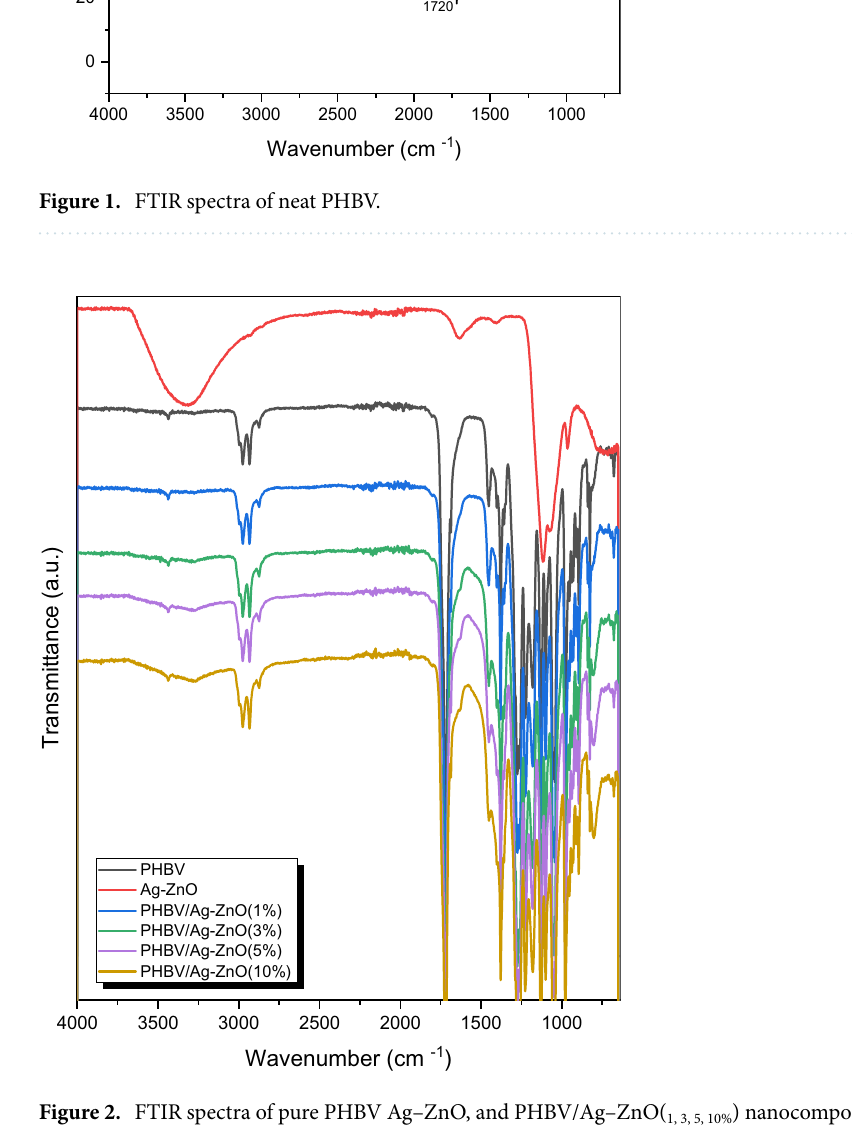
Figure 2. FTIR spectra of pure PHBV Ag–ZnO, and PHBV/Ag–ZnO( 1, 3, 5, 10% )